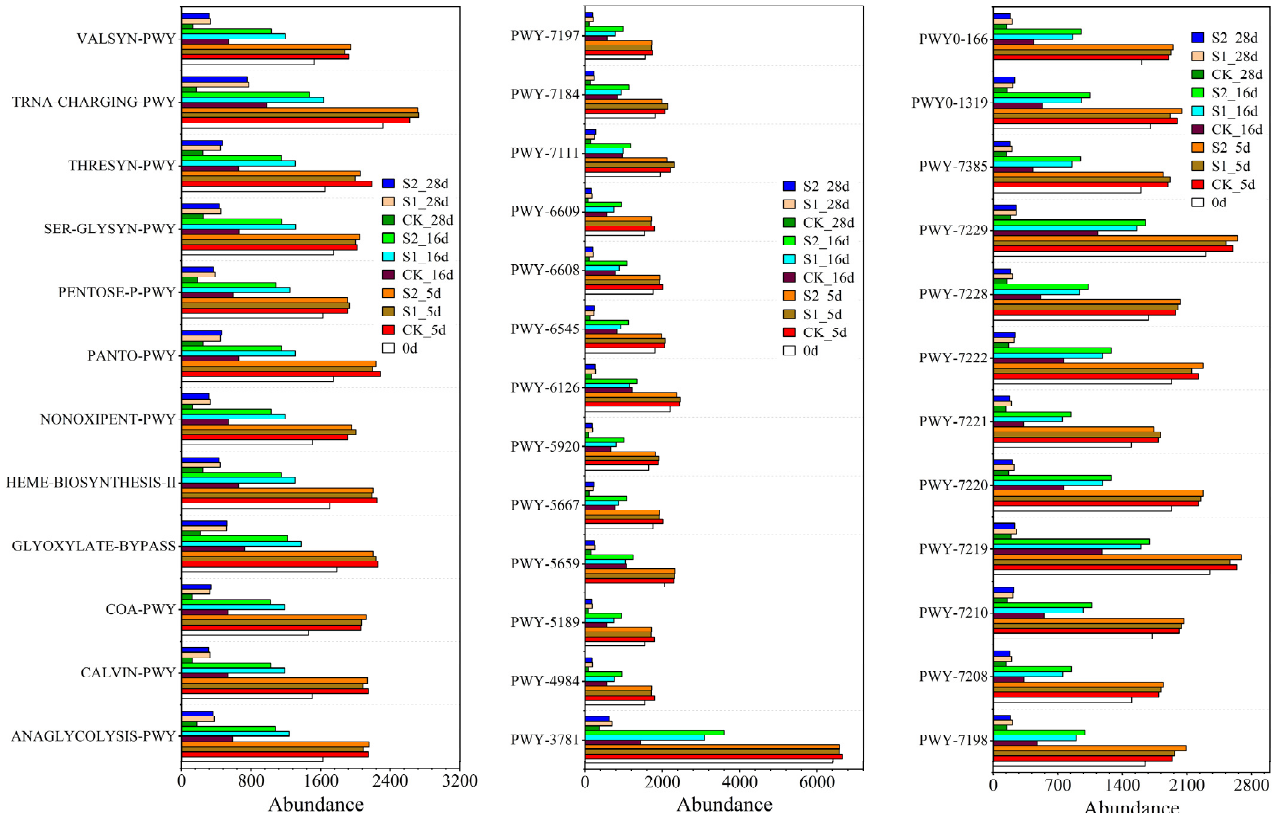
Figure 4. Prediction of the abundance of different metabolic pathways based on PICRUSt2.